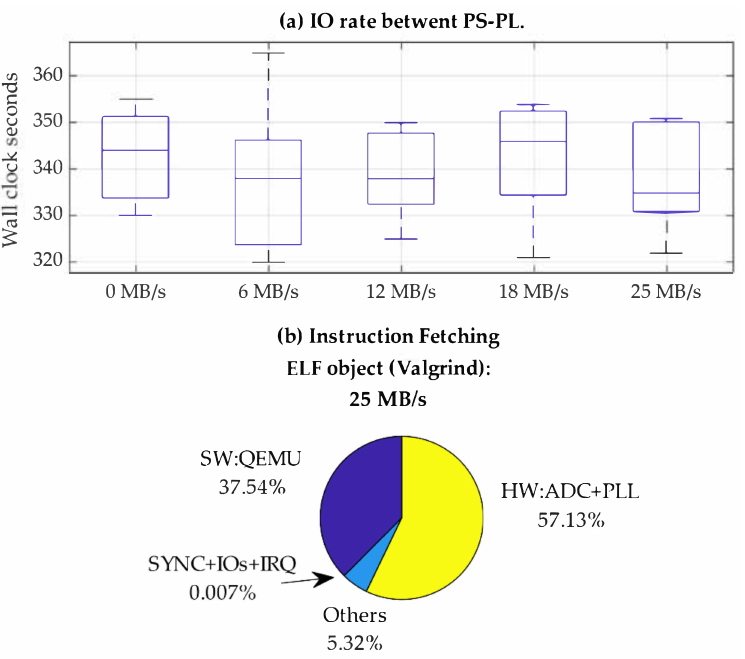
Figure 14. Linux + ADC + PLL micro-grid monitoring system results: ( a ) time (wallclock) results